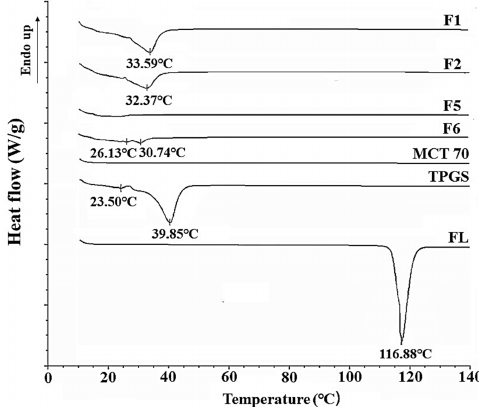
Figure 2. Differential scanning calorimetry (DSC) thermograms of F1, F2, F5, F6, Kollisolv MCT 70, TPGS and FL.